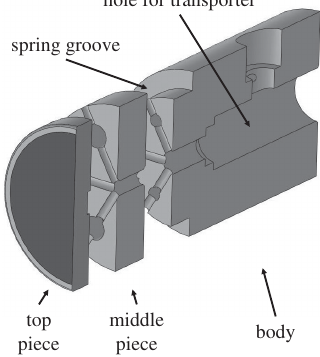
FIG. 1. Cutaway drawing of the cathode assembly. The dark part of the top piece represents the (N)UNCD material. The vented screws holding the parts together are not shown.